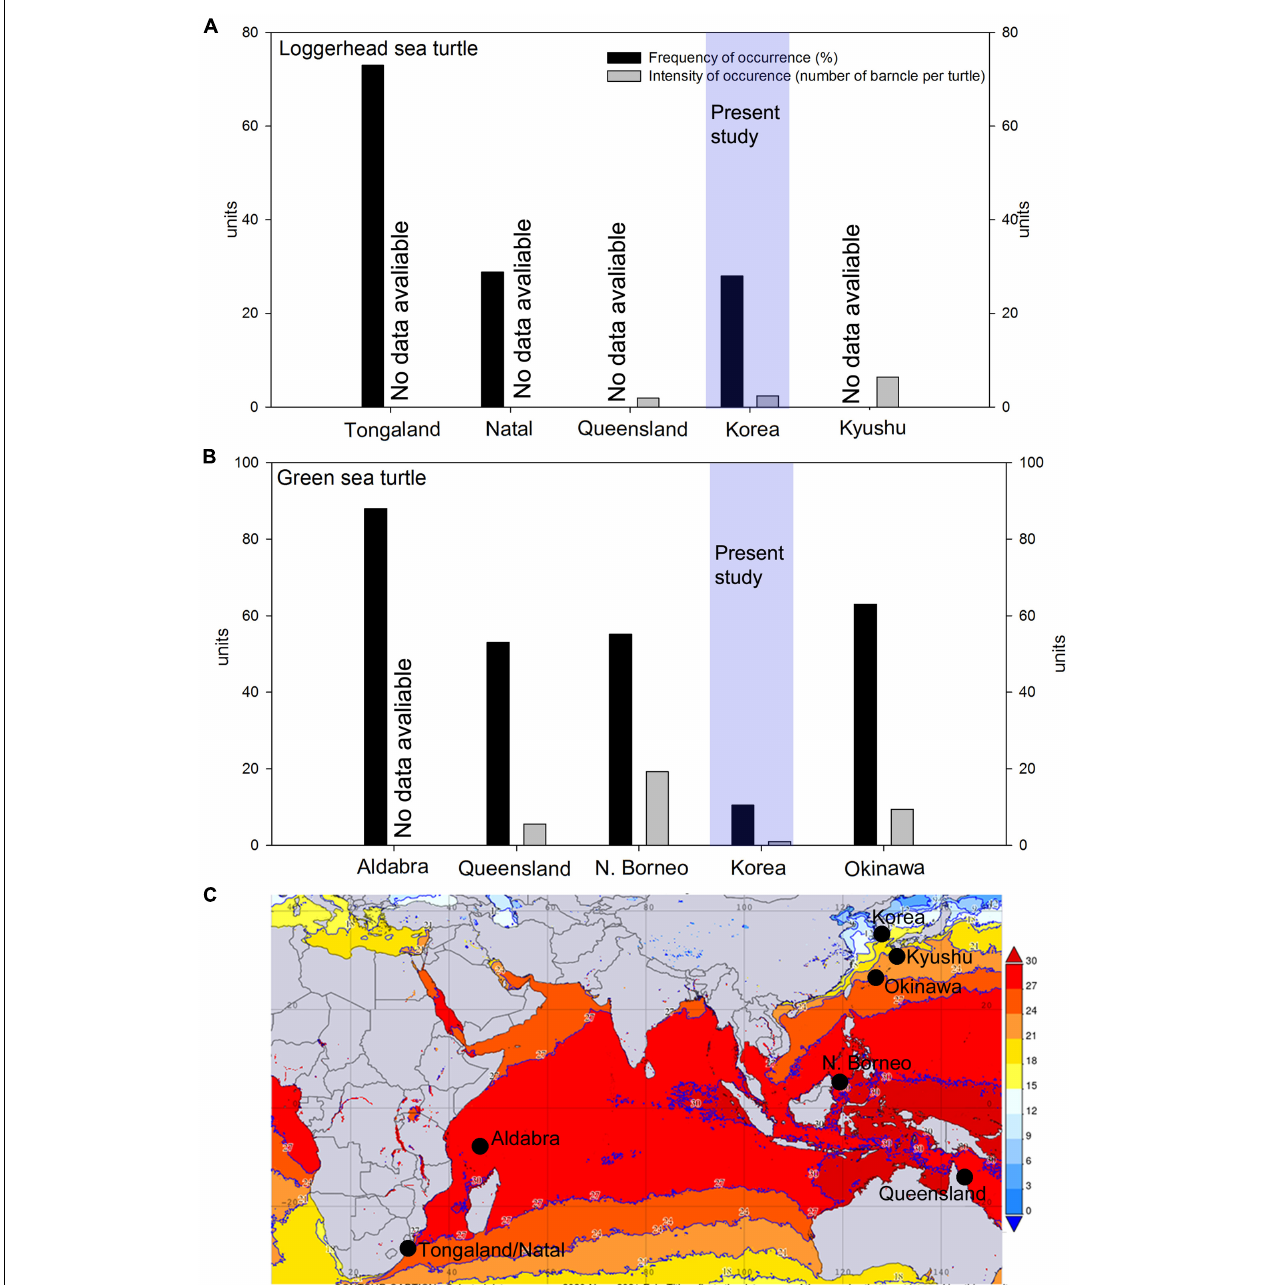
FIGURE 4 | Comparison of the frequency of occurrence (%, black bar) and intensity of occurrence (number of barnacles per turtle, gray bars) in the Indo-Pacific of (A) Loggerhead sea turtles and (B) Green sea turtles in Korea. Data sources from geographical population: Okinawa (Hayashi and Tsuji, 2008), Queensland in Australia (Limpus et al., 1994; Doell et al., 2017), Aldabra Atoll (Frazier, 1971), Mabul Island in N. Borneo (Lim et al., 2021), and Natal and Tongland (Hughes, 1974). The frequency of occurrence of barnacles on loggerhead sea turtles on Natal and the frequency of occurrence and intensity of occurrence of barnacles in green sea turtles in N. Borneo were averaged from the data on juveniles, subadults, and adults. For details, refer to Supplementary Table 1 ; (C) Averaged winter sea surface temperature map of the Indo-Pacific (November 2020–February 2021), generated from NASA Giovanni database version 4.36. Black dots show the locations in panels (A,B)